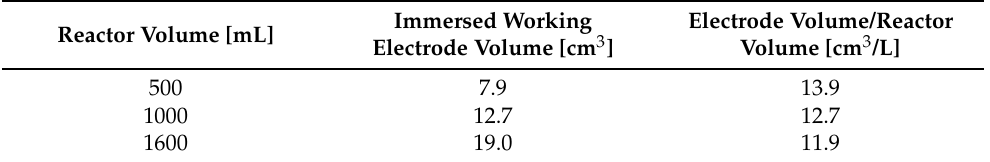
Table 1. Reactor volume, immersed working electrode volume and electrolyte volume to graphite working electrode volume ratio during the three different stages of